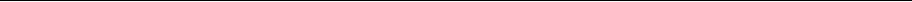
Table1.Listofanimalsusedforeachexperimentalmethod. Numberofanimalsandrouteofadministrationused at each age for (A) olanzapine monotherapy and modulation studies for both liquid scintillation counting and